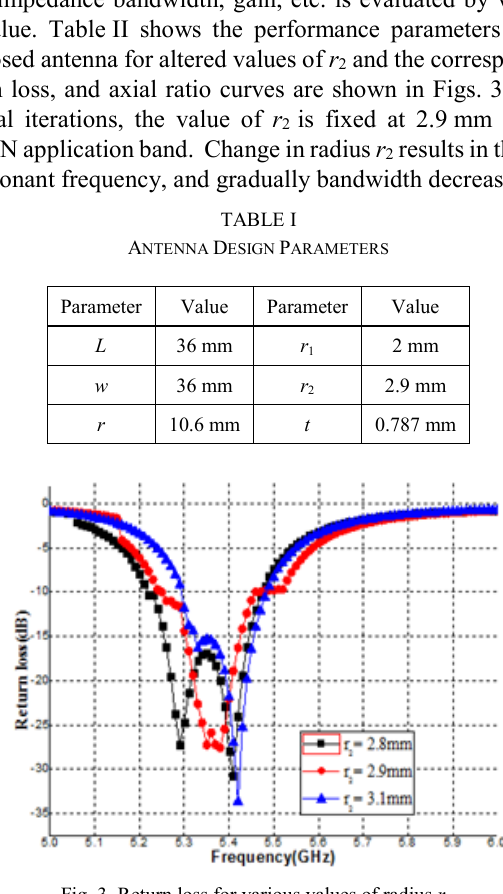
Fig. 3. Return loss for various values of radius r 2